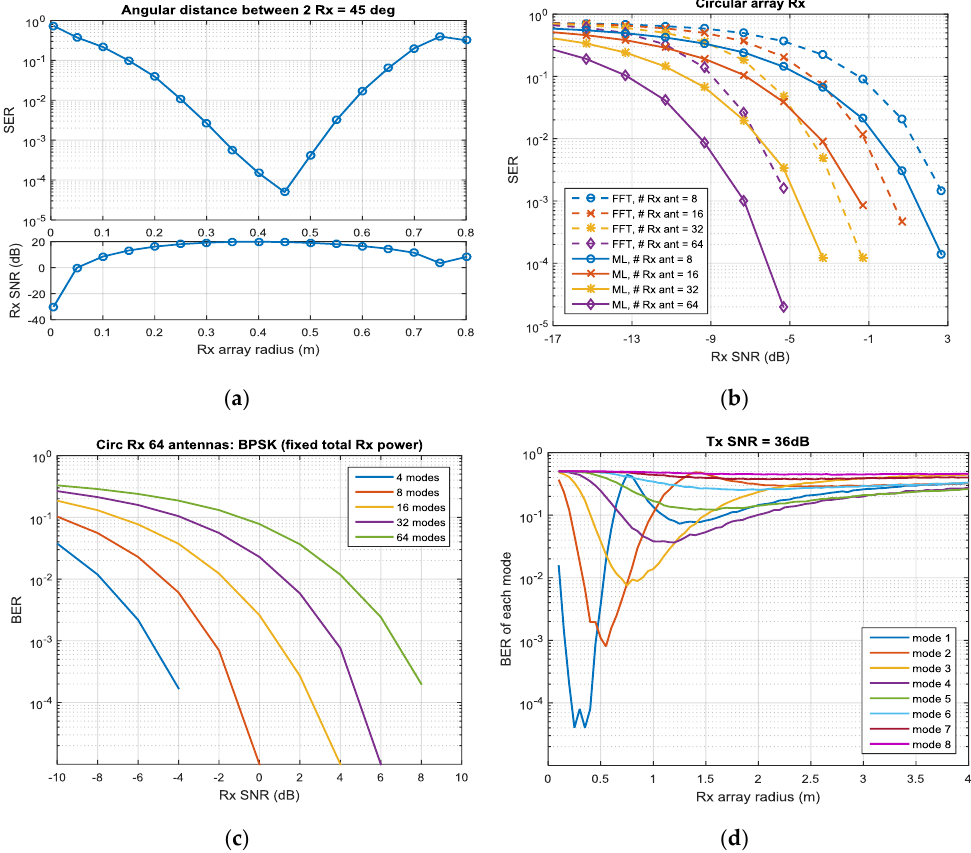
Figure 2. Performance evaluations of: ( a ) OAMSK (phased gradient method with varying Rx array radius); ( b ) OAMSK (FFT-based and ML methods); ( c ) OAMDM with fixed Rx power; and ( d ) OAMDM with varying Rx array radius.